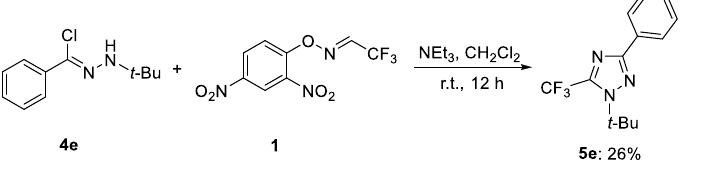
Figure 4. Scope of alkyl-substituted hydrazonyl chlorides. Reaction conditions: 4 (0.30 mmol), 1 (0.20 mmol), NEt 3 (0.60 mmol, 3.0 equiv), CH 2 Cl 2 (1.0 mL), r.t., 12 h, in benchtop air atmosphere. Isolated yields (calculated on basis of starting material 1